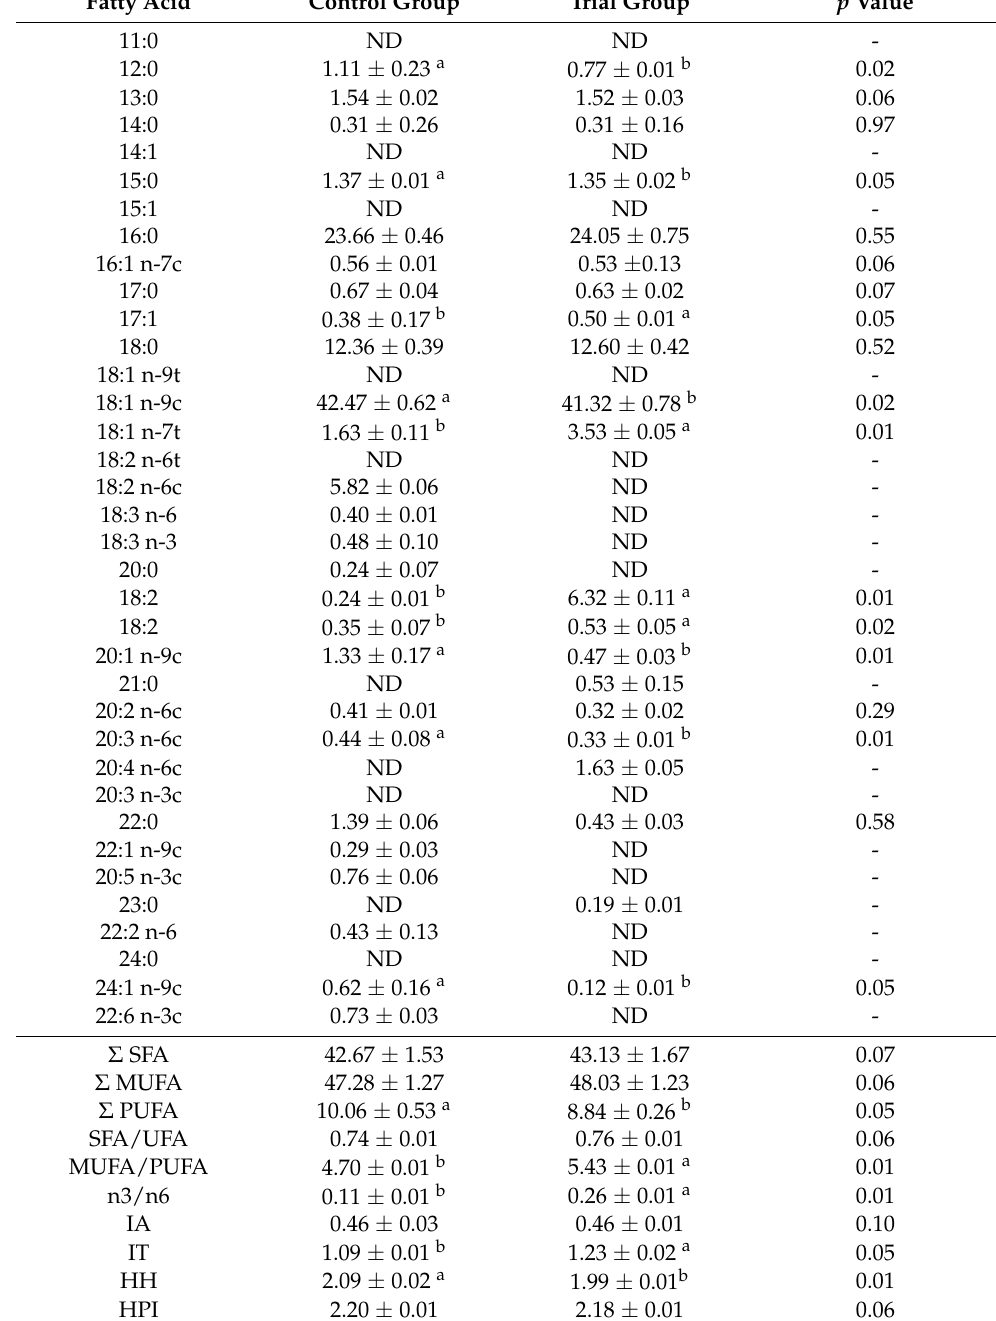
Table 7. Fatty acid profile (% dry weight) of M. longissimus thoracis et lumborum